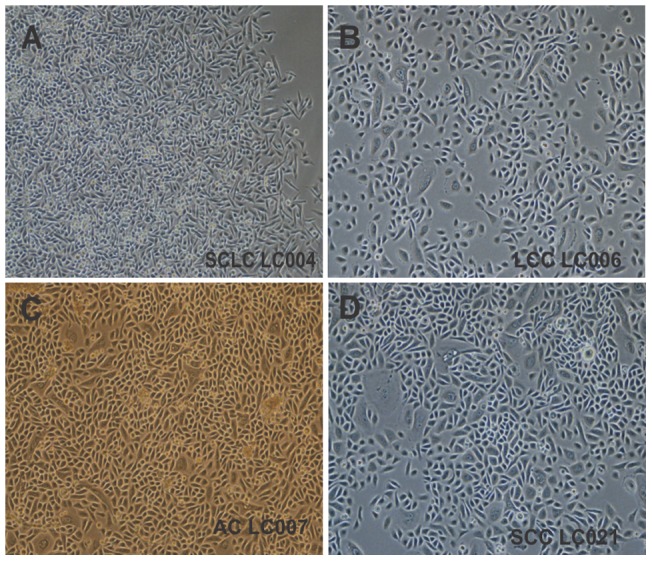
Typical epithelial cells were obtained at high purity under the serum-free condition.
A. The SCLC cell line LC004; B. The LCC cell line LC006; C. The AC cell line LC007; D. The SCC cell line LC021. All the representative images were from primary cultured lung cancer cell lines at the second passage. Photomicrograph magnification, ×200.